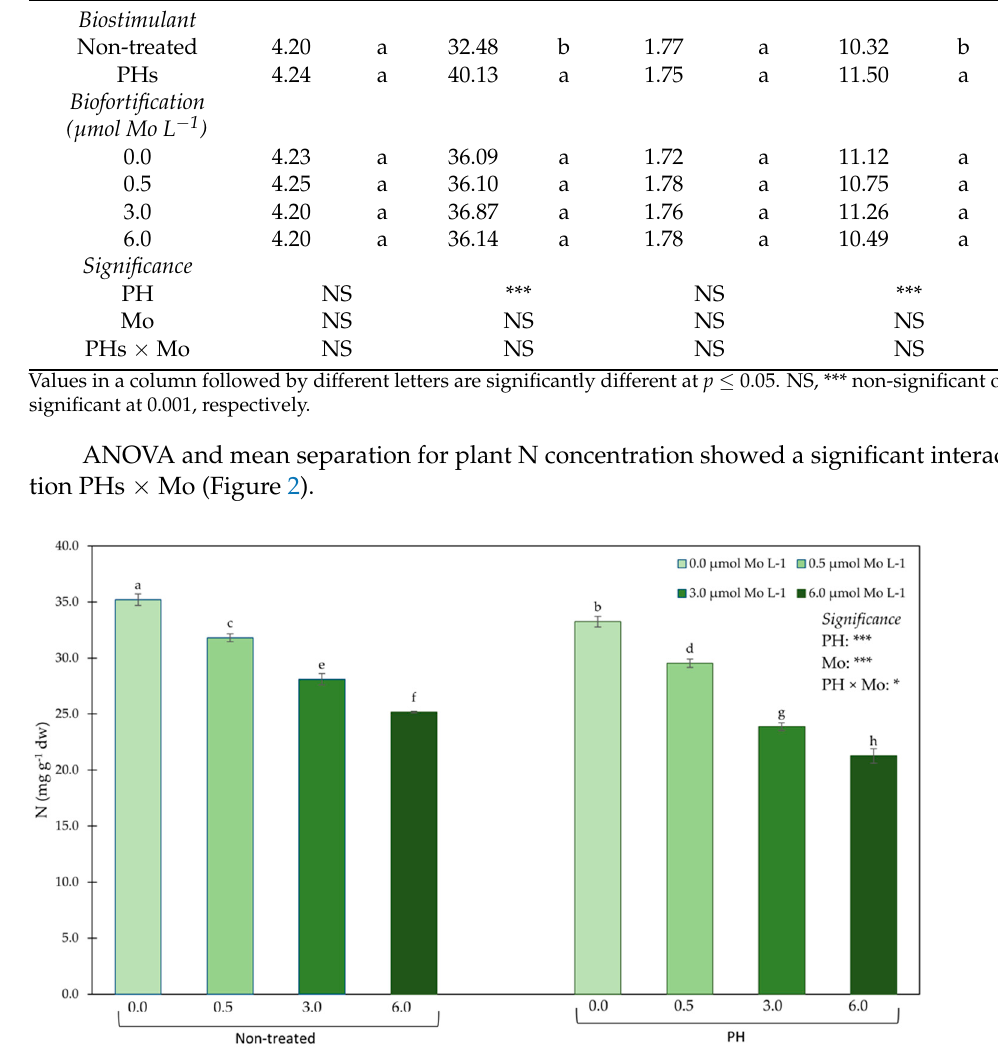
Figure 2. Effects of PHs and Mo treatments on nitrogen concentration in ‘Canasta’ lettuce leaves grown in a protected environment. Values with different letters significantly differ at p ≤ 0.05. *, *** significant at 0.05 and 0.001, respectively.